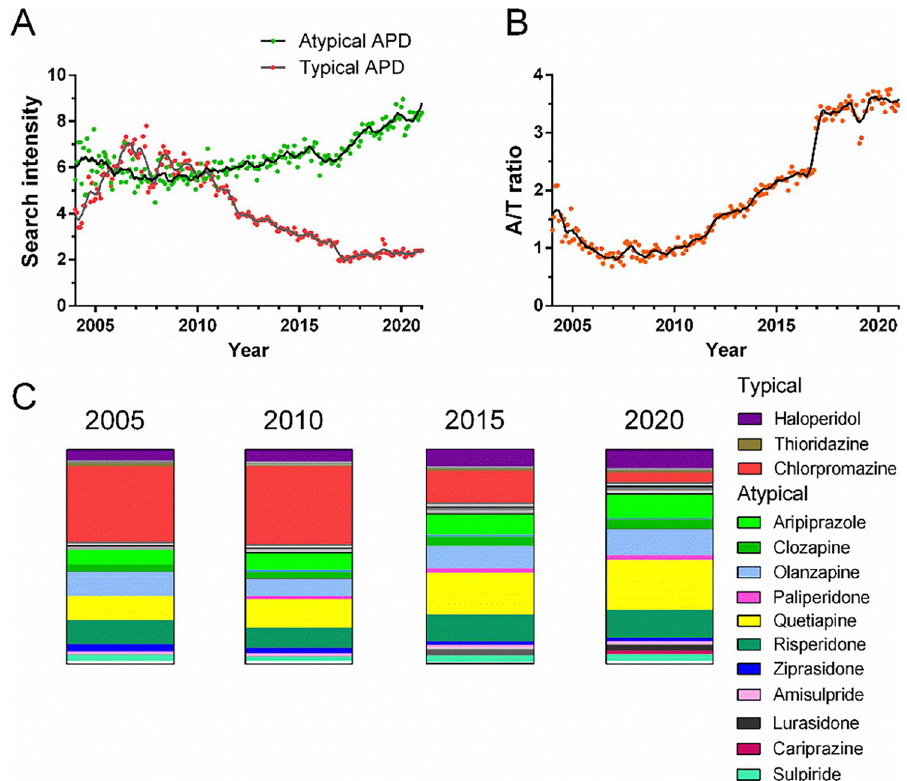
Figure 2. Global antipsychotic drug (APD) search intensities in 2004-2020. Data were normalized to the maximum search intensity of haloperidol. ( A ) Global typical (n = 19) and atypical APD (n = 22, see “Methods” section) search intensities over time. ( B ) Global atypical/typical APD search intensity (A/T) ratio over time. ( C ) Vertical slices demonstrate the relative search intensities for typical and atypical APDs in 2005, 2010, 2015, and 2020, with the most common APDs specified. See Supplementary Figs. S5–S6 and Supplementary Table S1 for search intensities of all included typical and atypical